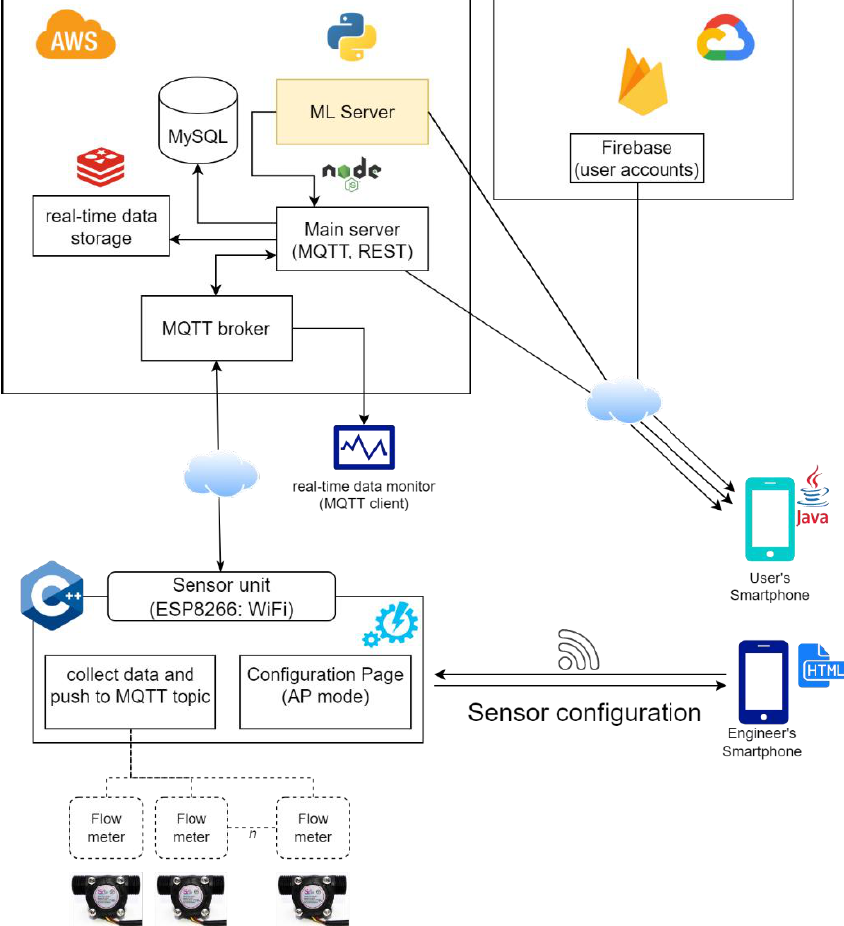
Figure 1. The water consumption monitoring system architecture.